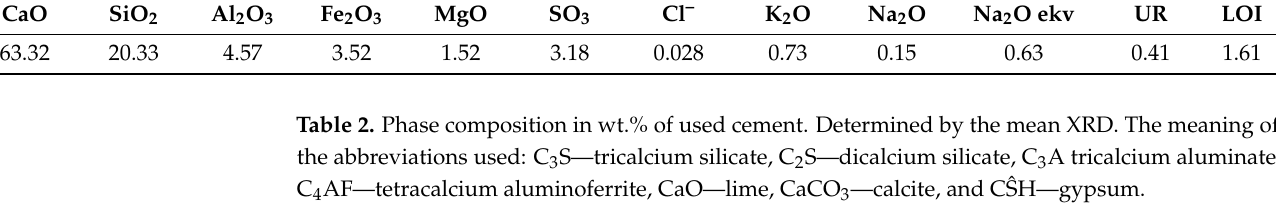
Table 1. Chemical composition of the cement according to EN 196-2. The abbreviations UR and LOI stand for unsoluble rest and loss on ignition, respectively.